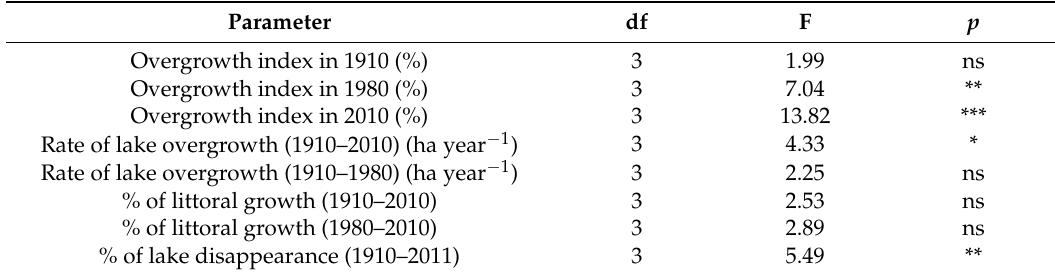
Table 1. Results of one-way ANOVA testing the differences in share of emerged vegetation in lakes (i.e., overgrowth index) in 1910, 1980 and 2010, and overgrowth rate, percentage of littoral growth and percentage of lake disappearances between four lake overgrowth groups. All parameters were transformed using Box–Cox transformation. Data are F ratios and significance levels given as *** p < 0.001; ** p < 0.01; * p < 0.05 and ns, p ≥ 0.05; df—degree of freedom.